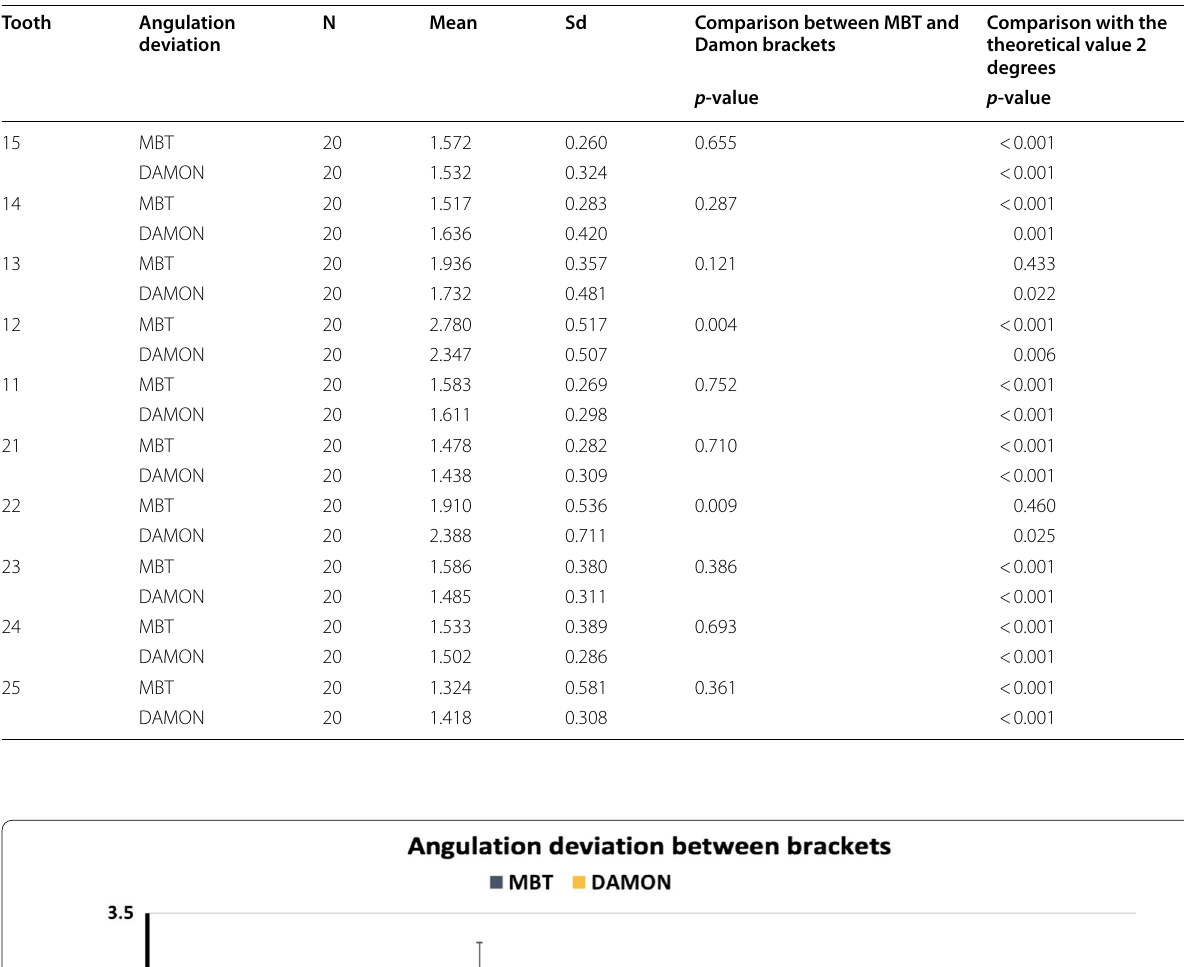
Table 4 Mean and standard deviation of the differences in angulation between direct and indirect methods using MBT and Damon